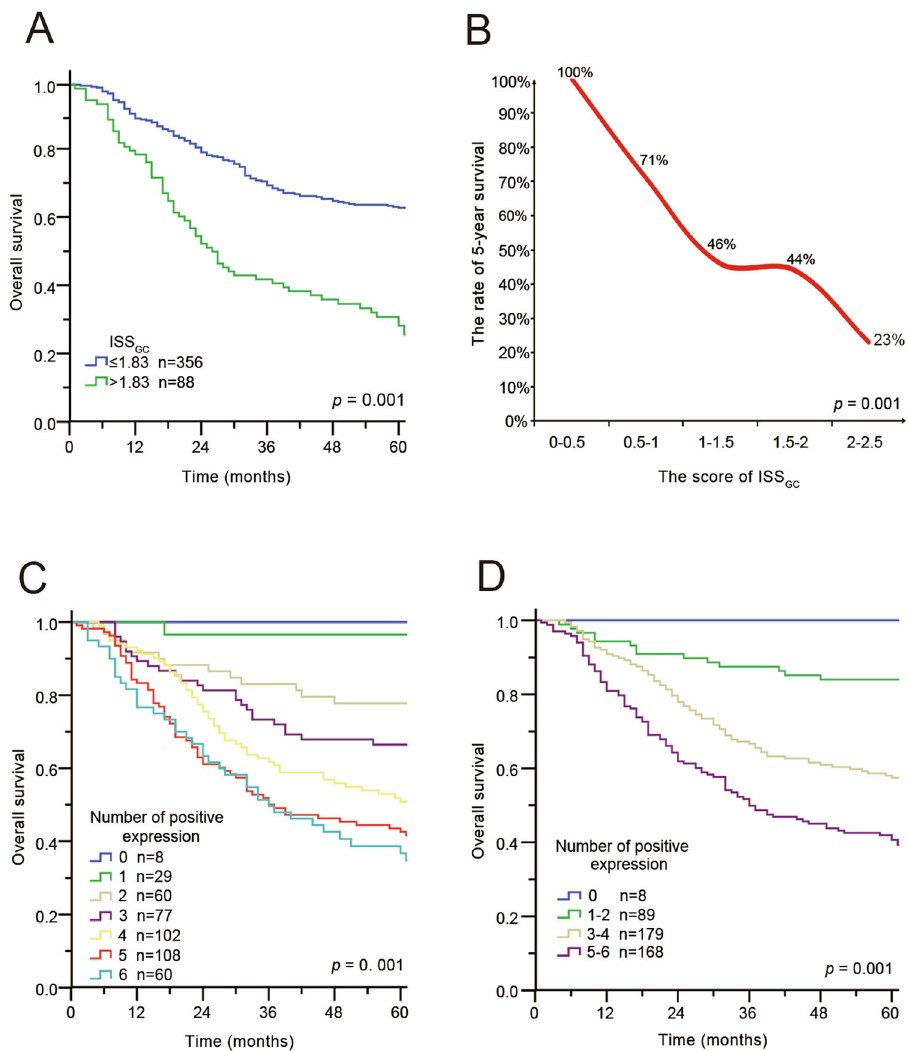
Fig. 3 Prognostic value of ISS GC . A Kaplan – Meier curves for overall survival in GC patients according to the ISS GC . p -Values have been calculated using the log-rank test. B Negative correlation between survival rate and ISS GC . Statistical signi fi cance was determined by a two-tailed paired Student ’ s t -test. C , D Kaplan – Meier curves for overall survival in GC patients according to the number of positive ligands. p -Values for all survival analyses have been calculated using the log-rank